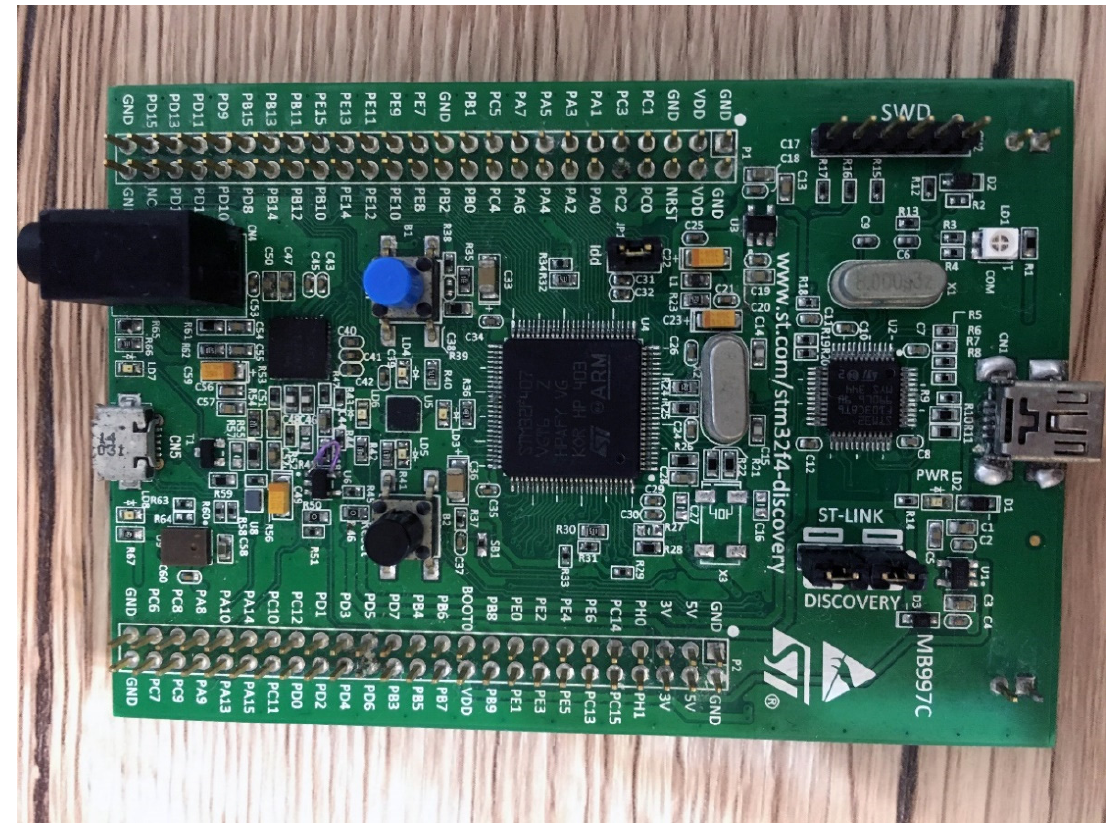
Figure 14. STM32F4-Discovery and 12-bit ADC.